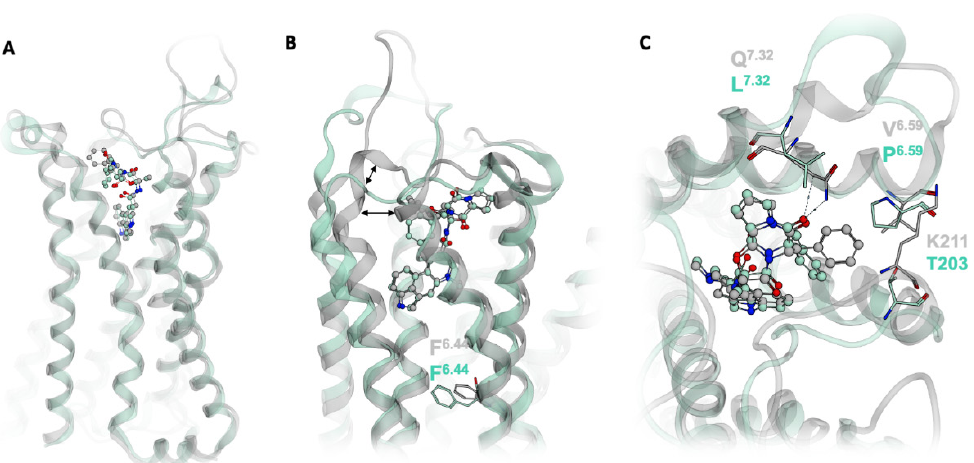
Figure 6. The structural basis of ergotamine’s di ff erential bias at the 5HT 1B R (green) and 5HT 2B R (grey). ( A ) Structural alignment of 5HT 1B R and 5HT 2B R. ( B ) Due to the additional helical turn at the top of 5HT 2B R TM5, the distance between TM5 and TM6 is shorter in 5HT 2B R. F 6.44 of the P-I-F motif is in the active conformation in 5HT 1B R and in an intermediate-active conformation in 5HT 2B R. ( C ) 5HT 2B R forms two additional hydrophobic contacts to ergotamine, at K211 and V 6.59 . In the 5HT 2B R TM7, ergotamine forms a hydrogen bond to Q 7.32 , which cannot be recapitulated by L 7.32 in 5HT 1B R.